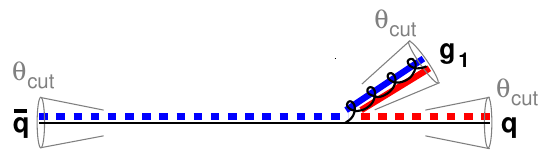
Figure 3. Illustration of the configuration that we consider to examine the equivalence between exact angular ordering and our partitioning of dipoles, as relevant for NDL accuracy in particle and jet multiplicities. We will consider the emission of a further soft gluon, g , with respect to this 2 configuration, at an angle of at least θ away from the ¯ q , q and g . The dashed/solid coloured cut 1 lines indicate schematically where we use a C v. C 2 colour factor for each of the two dipoles F A / (blue: ¯ qg , red g 1 1 q